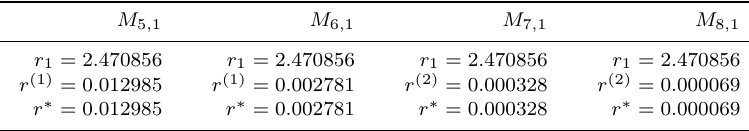
Table 3. Numerical results for example